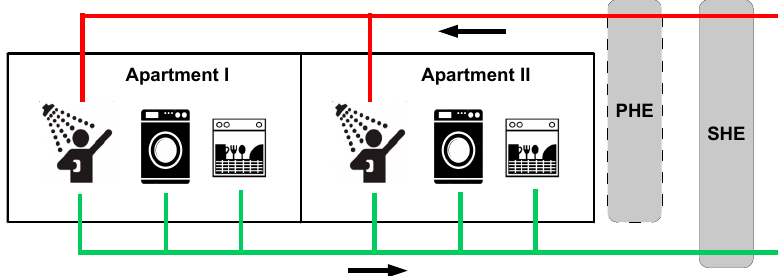
Figure 6. Two identical apartments equipped with IoT devices, i.e., a shower, a washing machine, and a dishwasher.